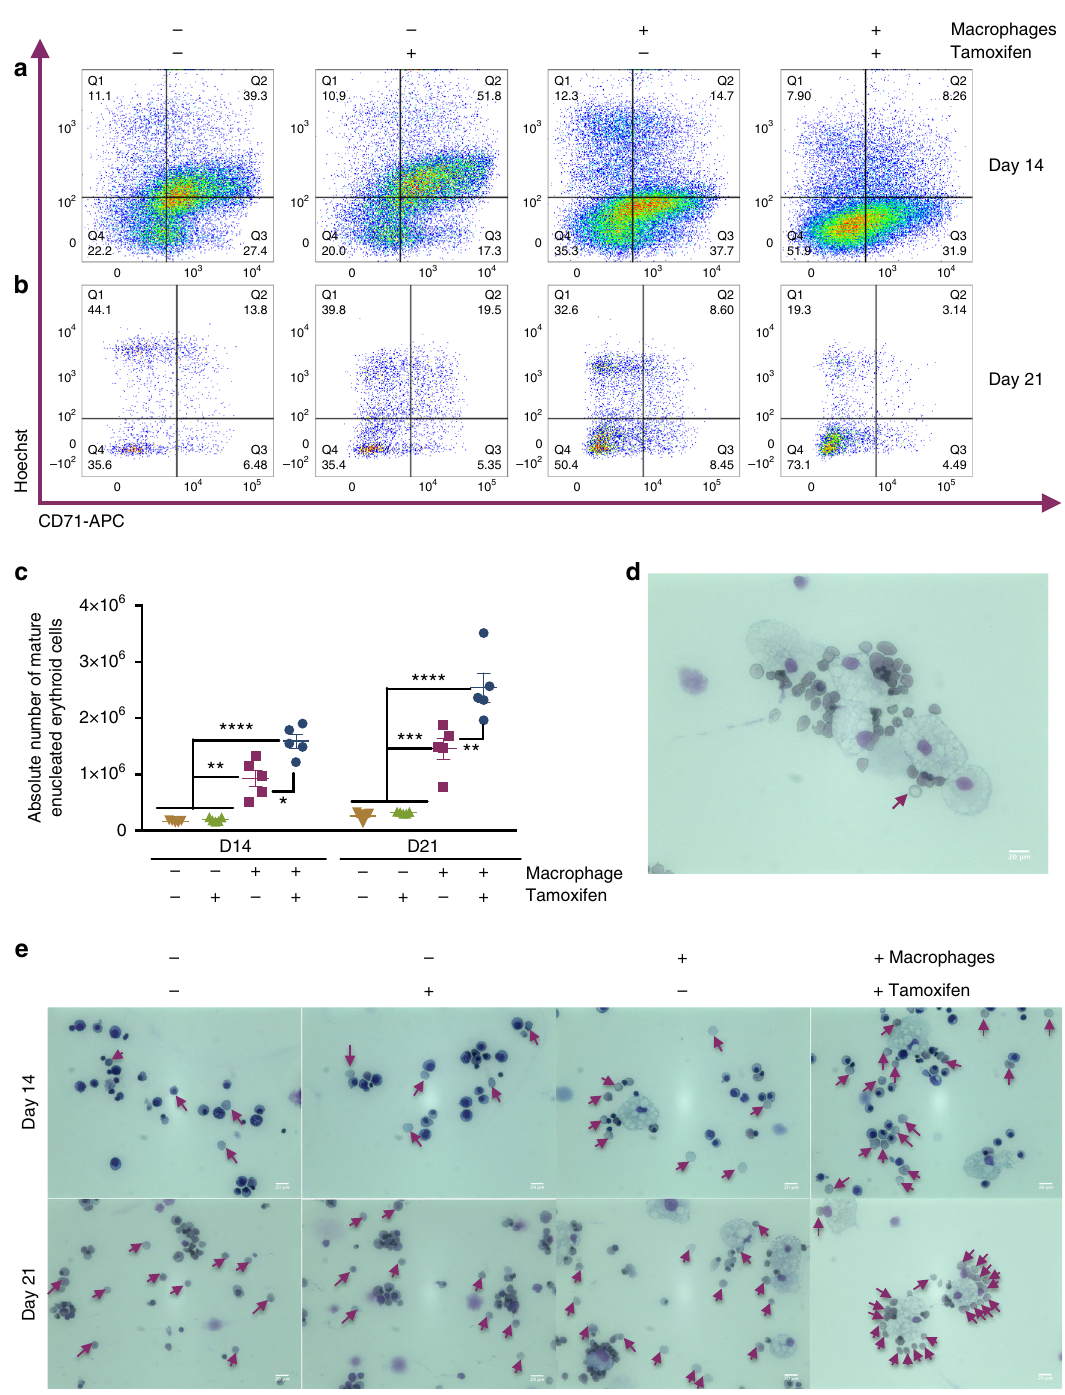
Fig. 3 KLF1-activated iPSC-DMs enhance erythroid maturation. a , b . Flow cytometry analyses of live CD235a + -gated cells of UCB-CD34 + erythroid cells cultured alone or in co-culture with iKLF1.2-DMs in the presence and absence of tamoxifen at day 14 ( a ) and day 21 ( b ) stained with anti-CD71 antibody and Hoechst dye (see Supplementary Fig. 3 for gating strategy and FMO controls). c Quanti fi cation and statistical analysis of absolute numbers of fully mature enucleated erythroid cells of replicate co-culture experiments ( n = 5 biologically independent samples; two-way ANOVA with Tukey ’ s post-test). d Cytospin of co-culture of KLF1-activated macrophages and UCB CD34 + cells showing close association and a fully mature erythroid cell with biconcave shape (arrow) (scale bar, 20 μ m). e Cytospins of UCB CD34 + erythroid cells cultured alone or in co-culture with iKLF1.2-DM in the presence and absence of tamoxifen at day 14 (upper panels) and day 21 (lower panels); arrows point to enucleated cells (scale bar, 20 μ m). * p < 0.05, ** p < 0.01, *** p < 0.001, **** p <